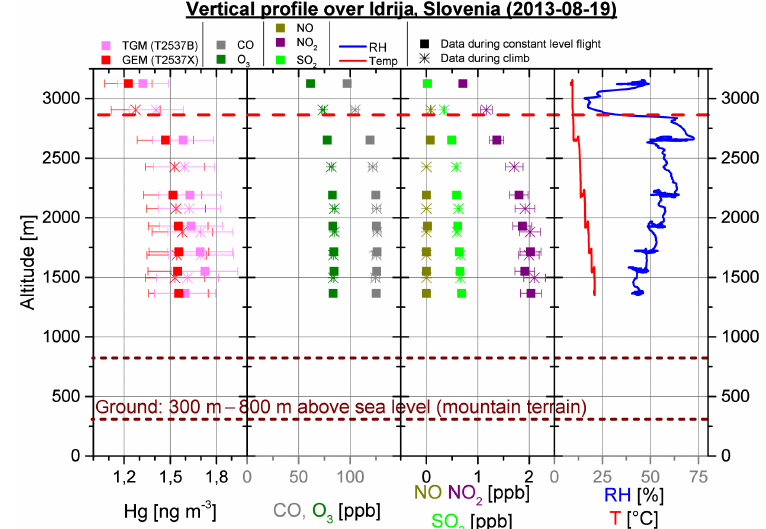
Figure 4. Same as Fig. 3, but for the former mercury mining area Idrija (45.000 ◦ N, 14.022 ◦ E, elevation: 330m; mountain terrain up to 800m). The profile was measured on 19 August 2013 from 14:30:00 to 15:20:00 (local time). The PBL top (red dashed line) was determined to be at 2850 to 2900ma.s.l. TGM and GEM concentrations are given at standard temperature and pressure ( T = 273.15K, p =